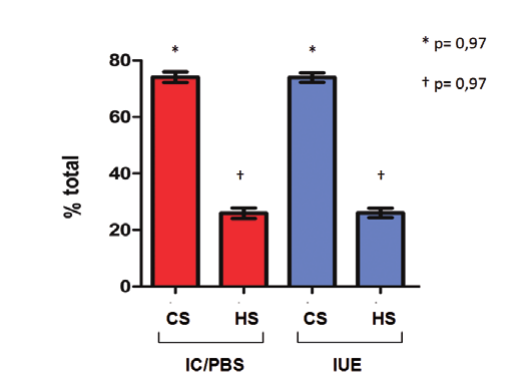
Figure 2 - Urinary concentration of sulfated GAG of IC/ PBS and control (SUI) patients. Vertical bars represent the standard deviations. Statistically significant difference was found between groups (p < 0.05).